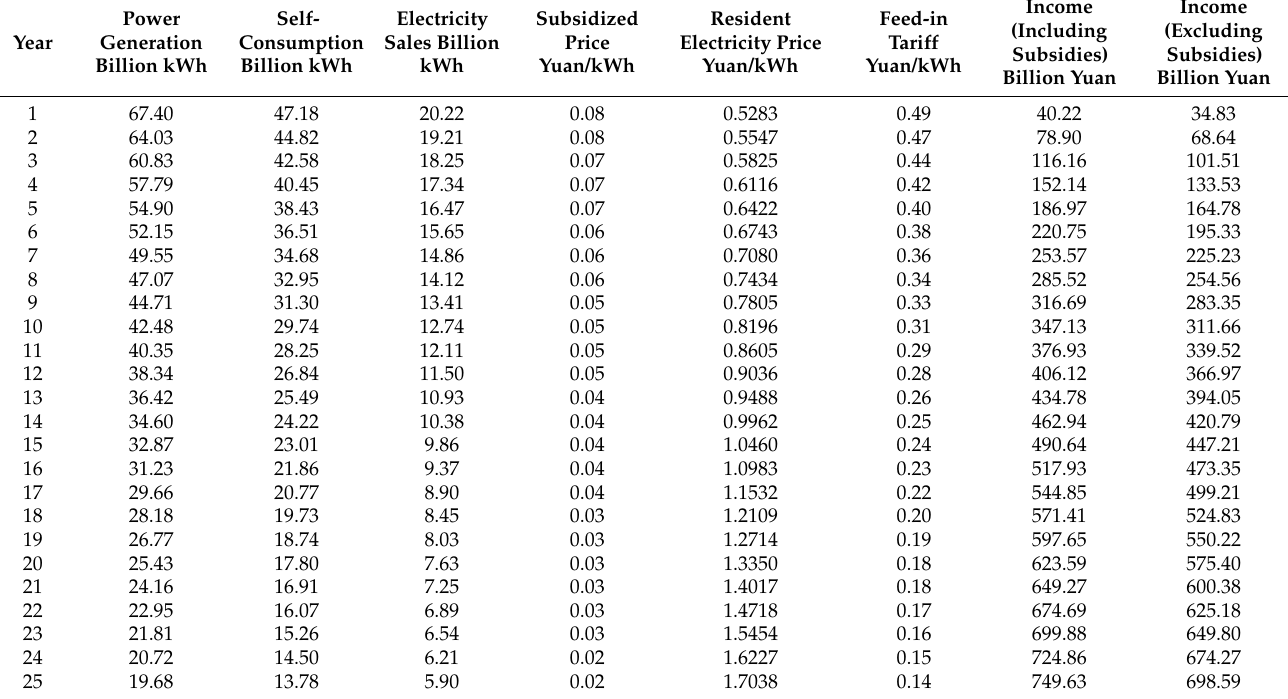
Table 7. 25-year income of urban photovoltaic installations in Jiangsu